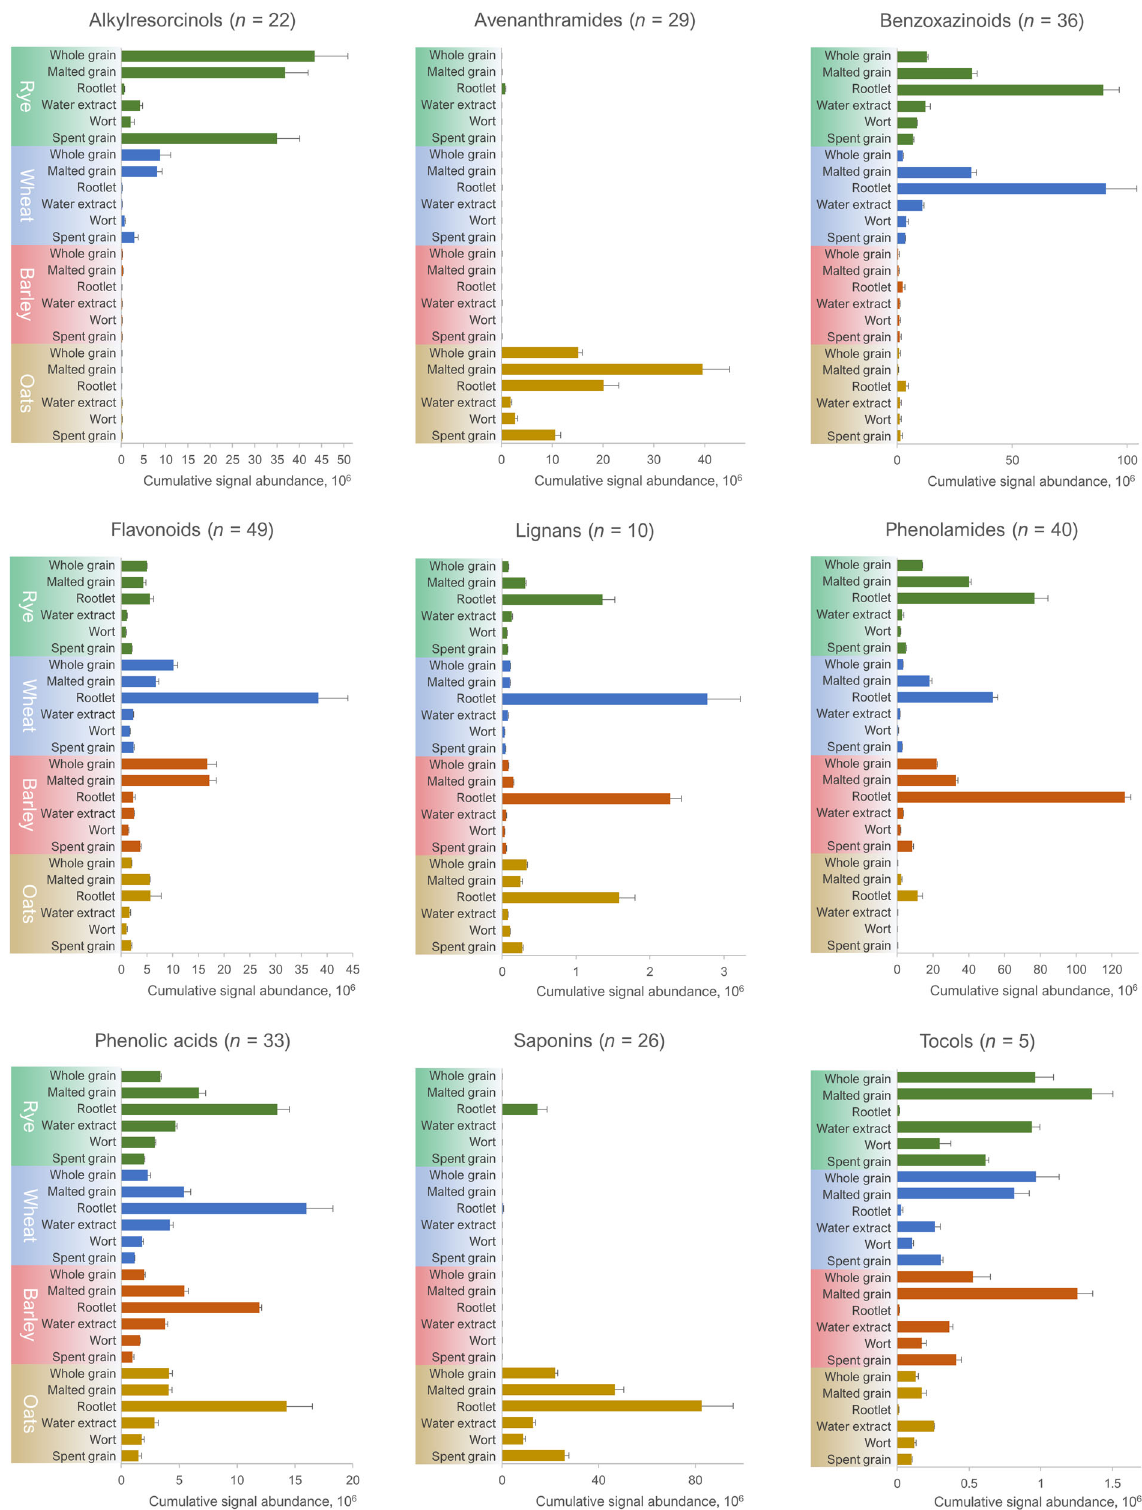
Fig. 4 Cumulative abundances of phytochemical classes in the studied samples. The relative abundance of nine phytochemical classes (as cumulative signal abundance of each annotated compound) during the malting process and in the side products (rootlet and spent grain) of four cereal species. The error bars correspond to one standard deviation within the three replicates per sample group. The abundances from water extract and wort are based on wet